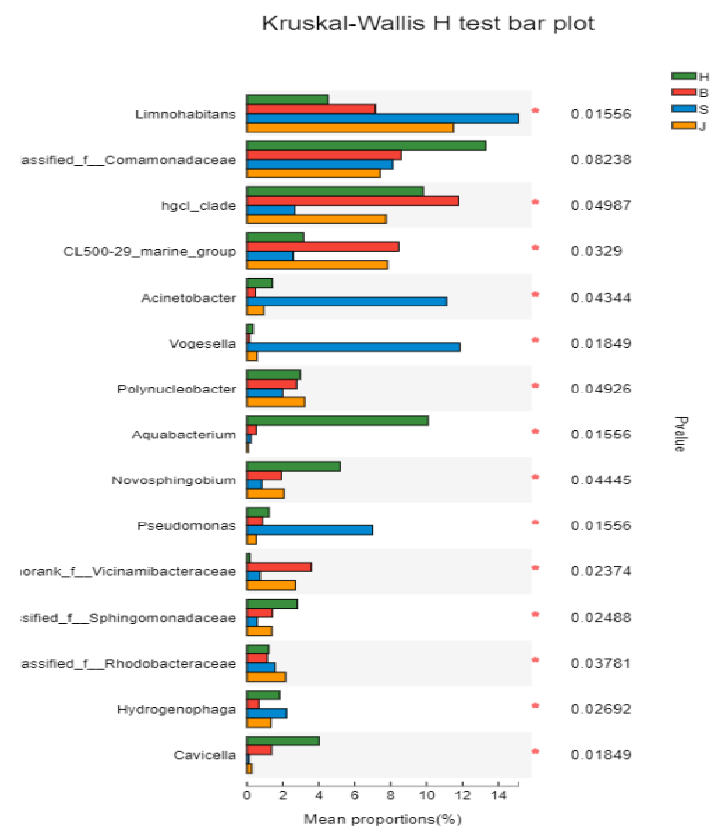
Figure 7 . Kruskal – Wallis H test analysis results. (The left side of the vertical axis represents the species name and the right side is the p -value. The abscissa represents the relative abundance. H represents the Hechuan District, S represents the Shapingba District, J represents the Jiangbei District, and B represents the Beibei District.).